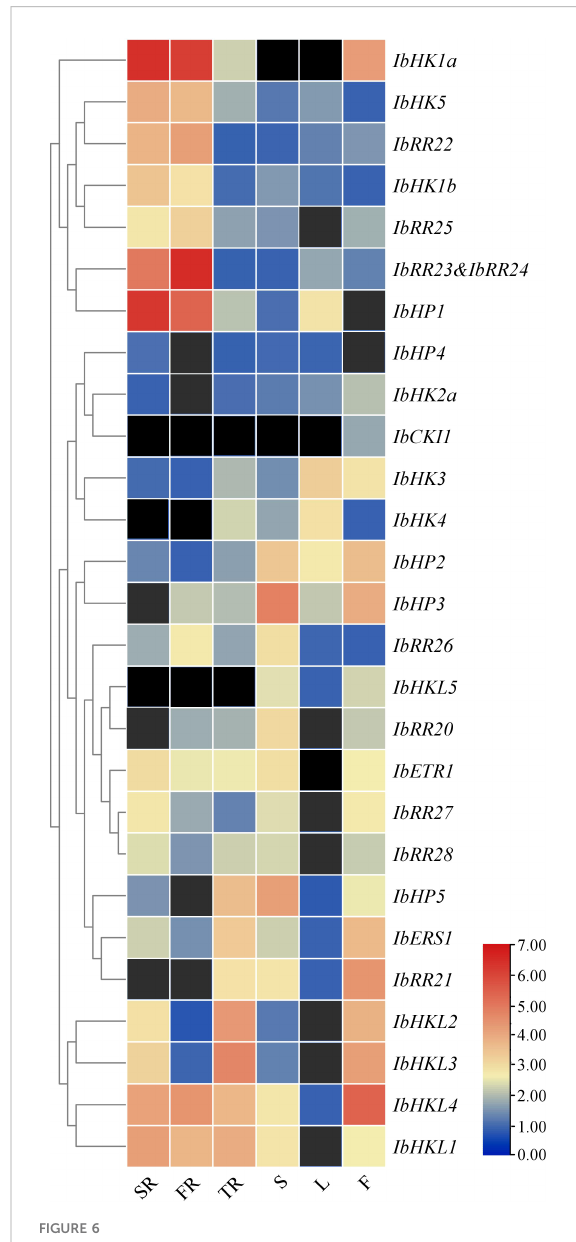
FIGURE 6 Heat map representation for the organ-speci fi c TCS gene expression pro fi les in Ipomoea batatas . SR, stem roots, FR, fi brous roots, TR, tuberous roots, S, stems, L, leaves and F, fl owers. The expression levels of genes are presented using fold- change values transformed to Log 2 format. The Log 2 (fold- change values) and the color scale are shown at the bottom of heat map. Genes that were not expressed were shown with black